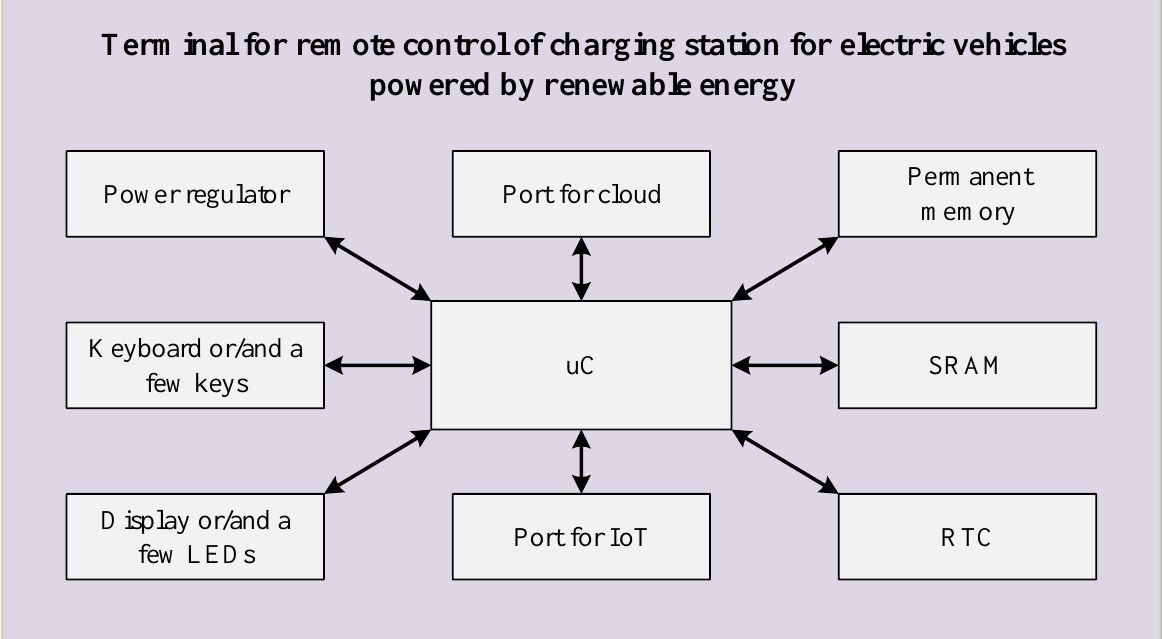
Figure 6. Block schematic of the hardware for the terminal. A minimum of two ports are available on the terminal, one of which is used to com- municate with the cloud and the other to the IoT network infrastructure [29]. As a result, a microcontroller should have at least two serial ports. Eventually, a microcontroller with only one serial port may be used, and the other serial port may be implemented using a separate integrated circuit. The microcontroller should have five serial ports in order to build